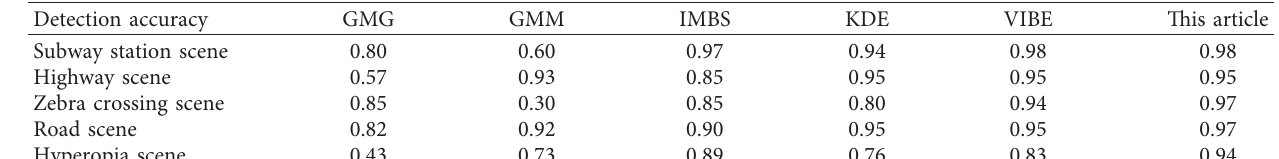
Figure 8: Speed detection speed indicator diagram for scene of dynamic background video library. Table 8: Data of accuracy index for camera shake video library scene detection.